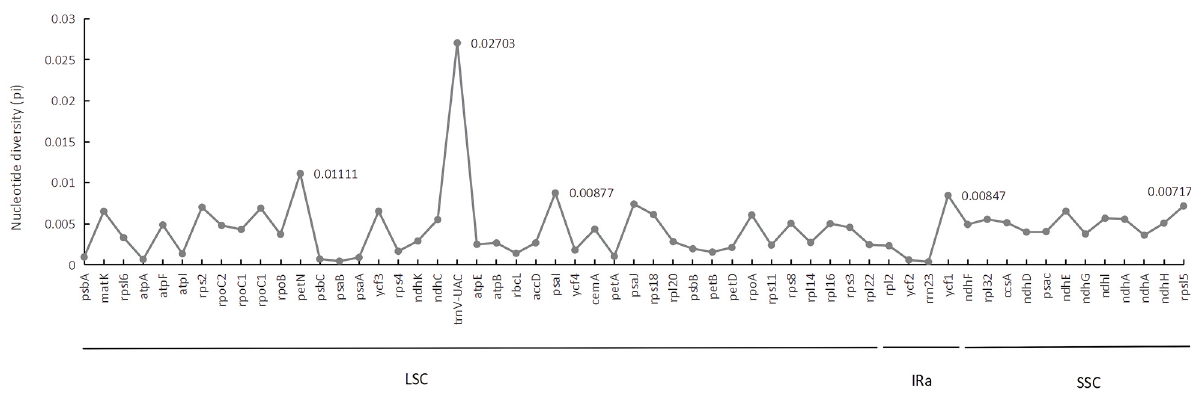
Figure 2. The nucleotide diversity ( π ) of coding regions between two Euonymus maackii Rupr. indi-